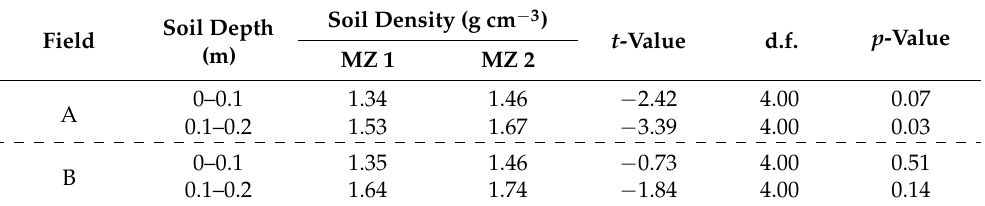
Table 3. Test of means for bulk soil density (Sd; g cm − 3 ) in each field investigated, according to the management zones (MZ 1 and MZ 2) delineated based on apparent soil electrical conductivity. Cachoeira do Sul, RS, BR.